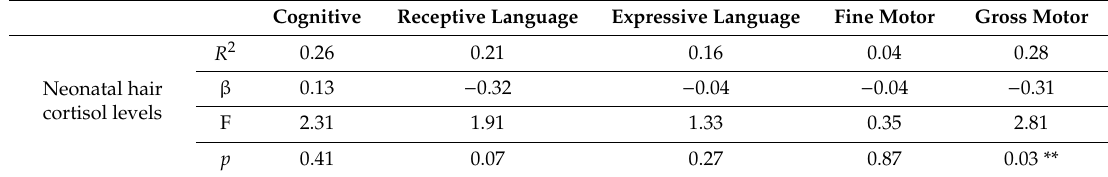
Table 4. Hierarchical regressions using neonatal hair cortisol levels as predictors of infant neurodevelopment.